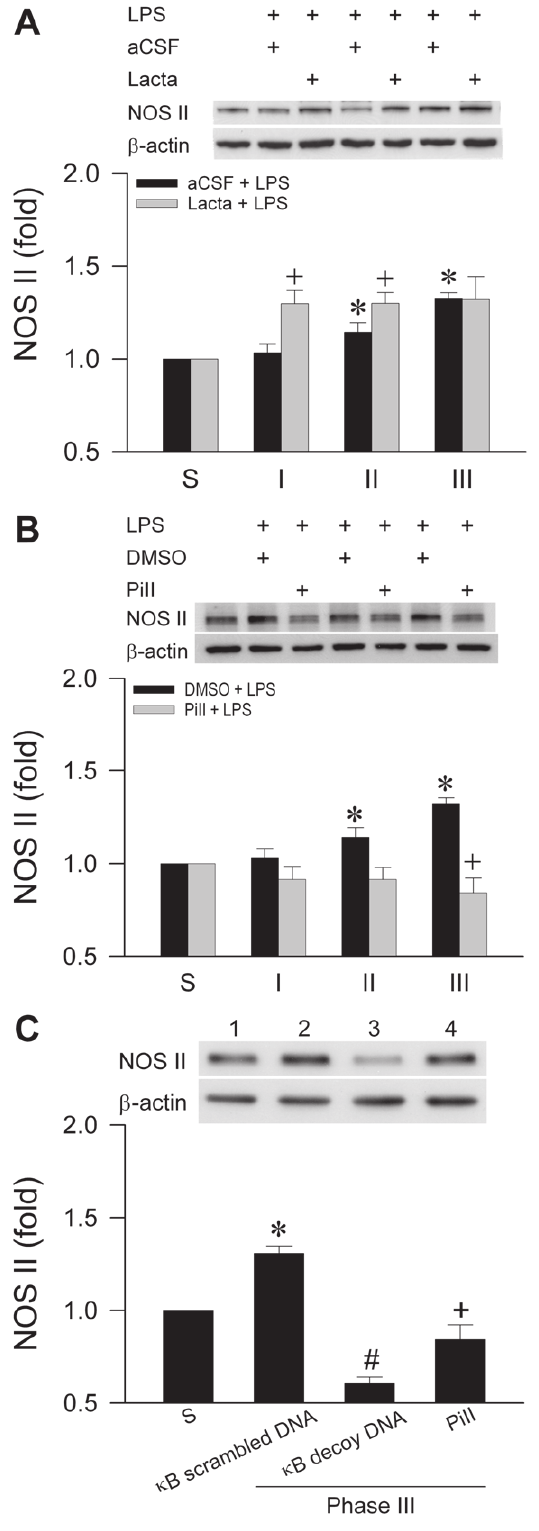
Figure 5. UPS is also engaged in the degradation of NOS II at RVLM. Illustrative gels or summary of fold changes against sham- controls of NOS II proteins detected by Western blot analysis in ventrolateral medulla of rats that received pretreatment by microinjec- tion bilaterally into RVLM of lactacystin (Lacta; 1 nmol) or aCSF (A), proteasome inhibitor II (PiII; 1 nmol) or DMSO (B) or scrambled or